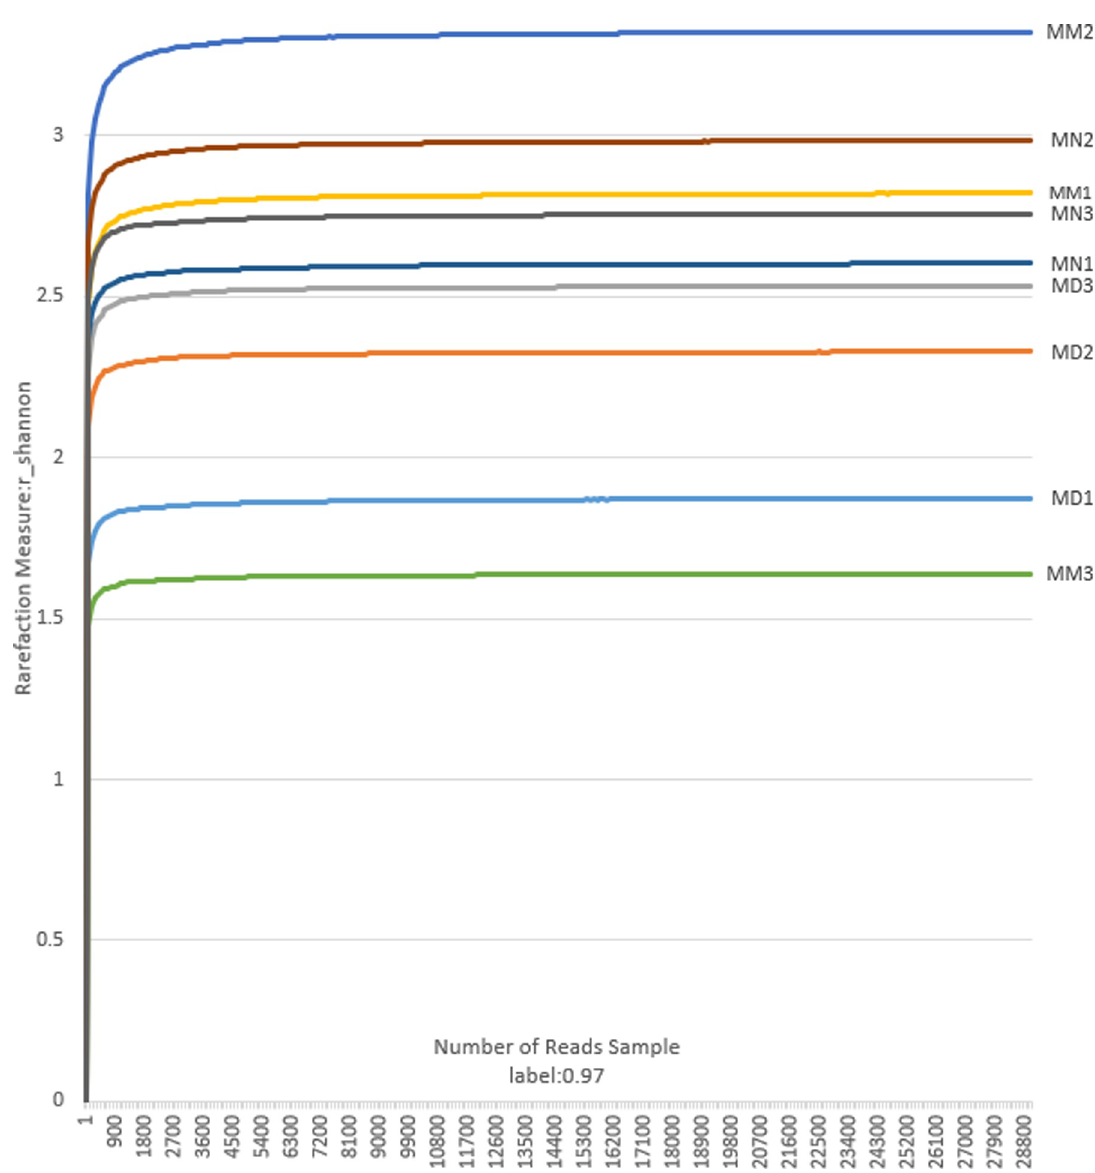
Fig 2. The Shannon index. The sparse analysis diagram of the Shannon index in the normal group (MN), the model group (MM) and the treatment group (MD).